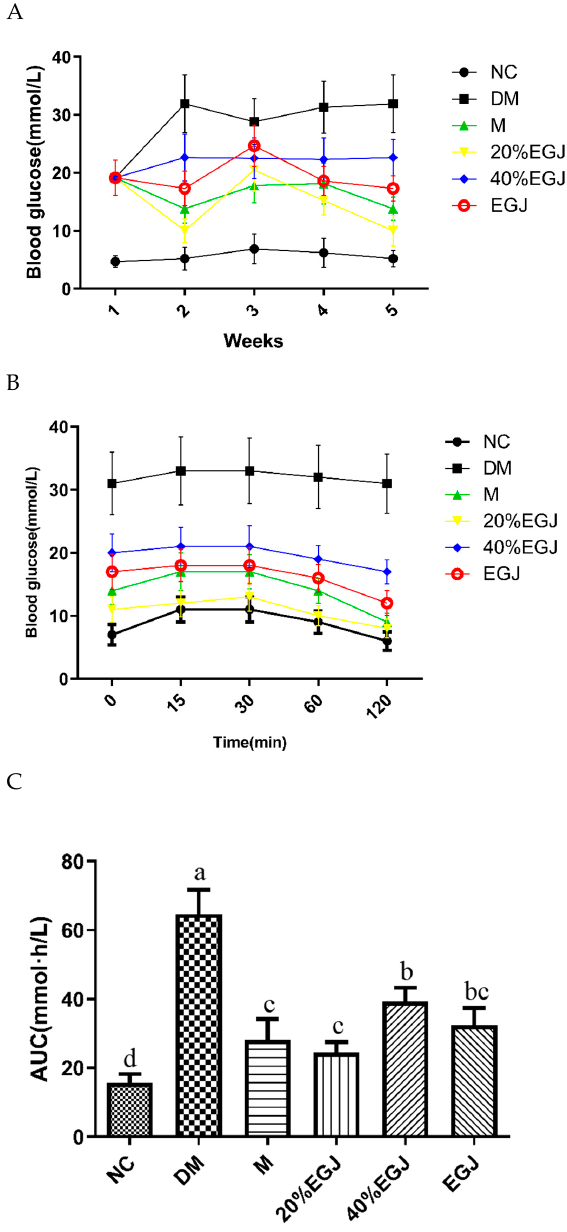
Figure 10. ( A – C ) represent the changes of the FBG, OGTT, and AUC, respectively. Note: the data were expressed as the mean ± the SD ( n = 9) and the different letters marked above the bars showed the significant differences ( p < 0.05).